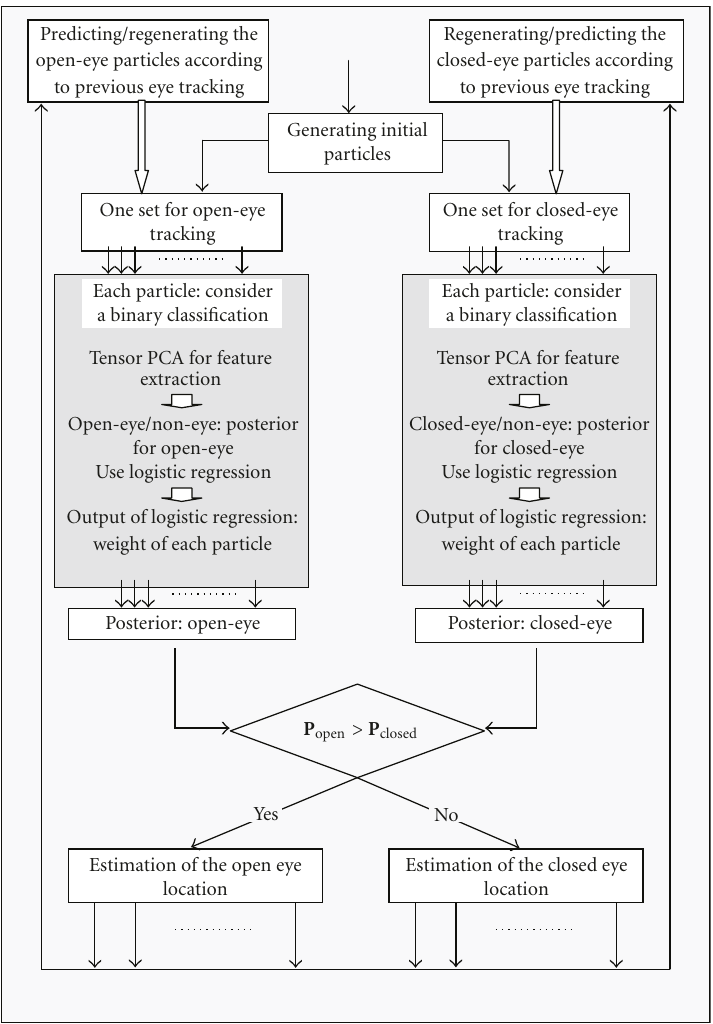
Figure 1: Flow-chart for eye blink detection system. For every new frame observation, new particles are first predicted from the known important distribution, and then updated accordingly based on the posterior estimated by logistic regressor in the tensor subspaces. The best estimation gives the class label (open-eye/closed-eye) as well as the eye